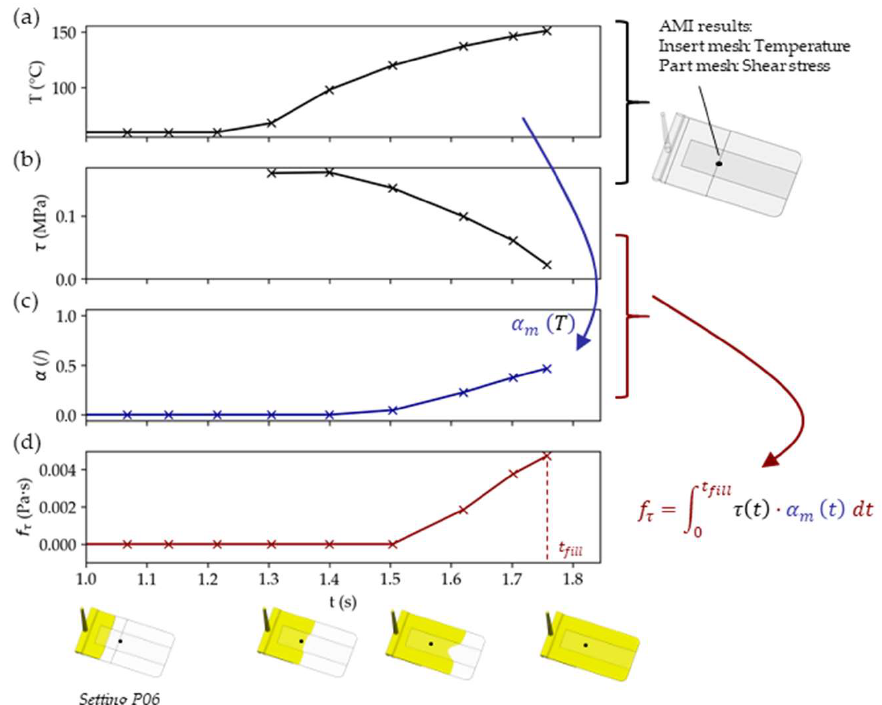
Figure 5. Schematic of the shear distortion factor ( f τ ) computation on the TPU layer for a node at the position indicated by the black point: The TPU layer’s temperature ( a ), at first at the set mold temperature, rises once the plastic melt reaches the film, which is also subjected to shear stresses ( b ). The TPU layer softens as indicated by the melted fraction ( c ) and the shear distortion factor, defined in Equation (1), increases until the part is filled ( d